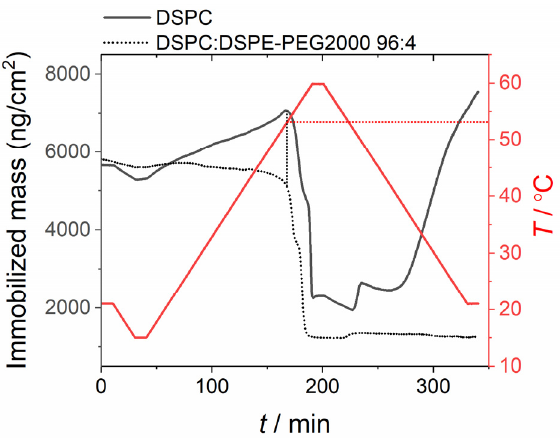
Figure 14. Effect of temperature on the mass (as determined by QCM-D) of immobilized liposome